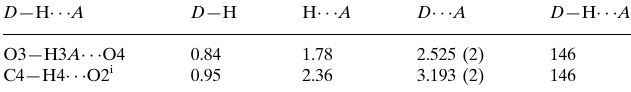
Hydrogen-bond geometry (A˚ , (cid:2)